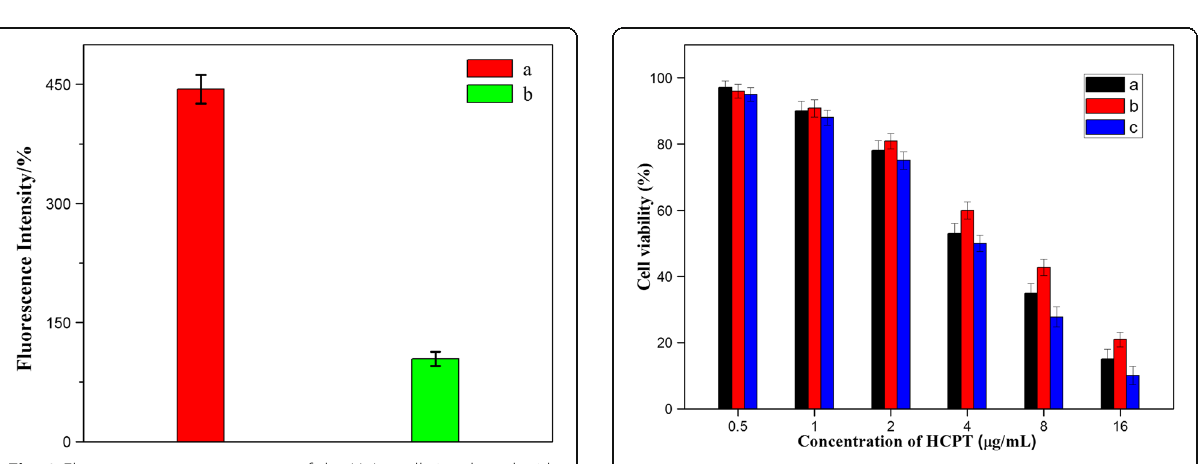
Fig. 10 In vitro cell viability of HeLa cells treated with ( a ) free HCPT, ( b ) NDs, and ( c ) HFNDs after incubation of 24 h. P <